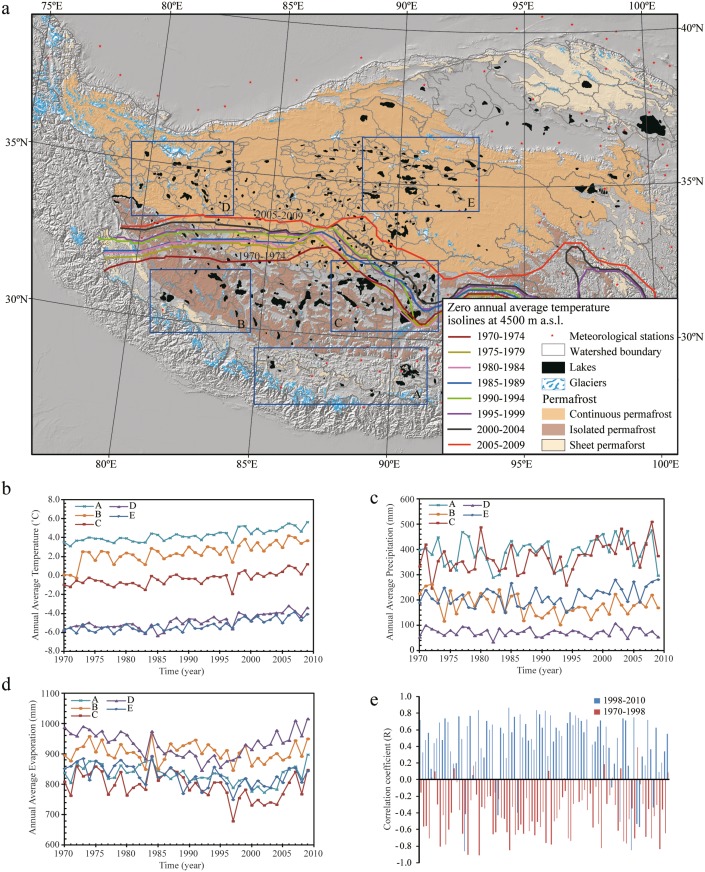
Climate variations on the Tibetan Plateau since the 1970s.a, Map showing the northward migration of 5-year annual average zero-temperature isolines (at 4500 m a.s.l). b, c, d, Variations in annual average temperature (b), precipitation (c), and evaporation (d) in five regions (A–E). e, Potential evapotranspiration trends before and after 1998 derived from meteorological stations within the Tibetan Plateau. The increasing or decreasing trends over time are represented by the correlation coefficient, R (R>0 indicates an increasing trend, and R<0 a decreasing trend).